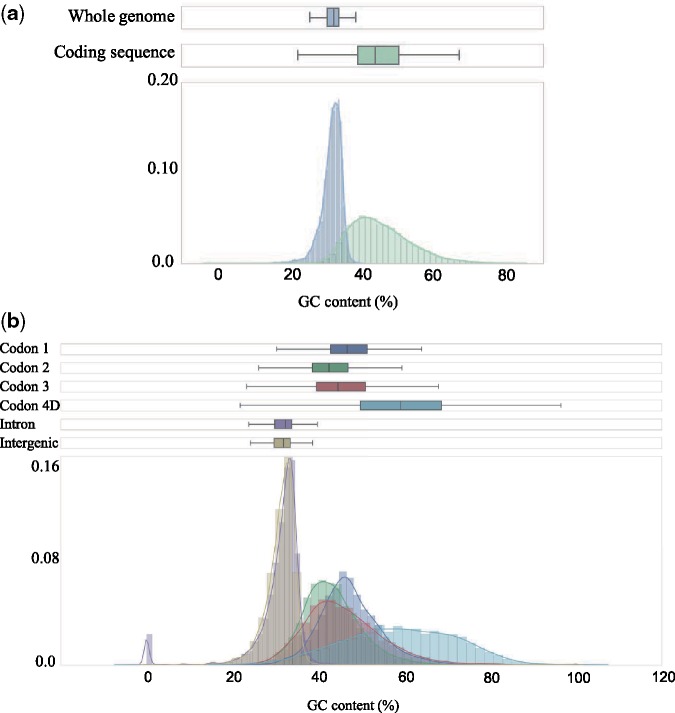
—The distribution of GC-content (%) across 100 kb windows for protein coding- and noncoding sequences (a) and for separate site categories (b).